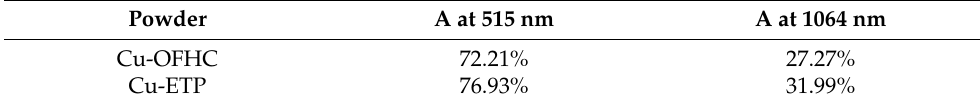
Table 3. Absorptivity A at 515 nm and 1064 nm measured with UV-VIS spectrometry.